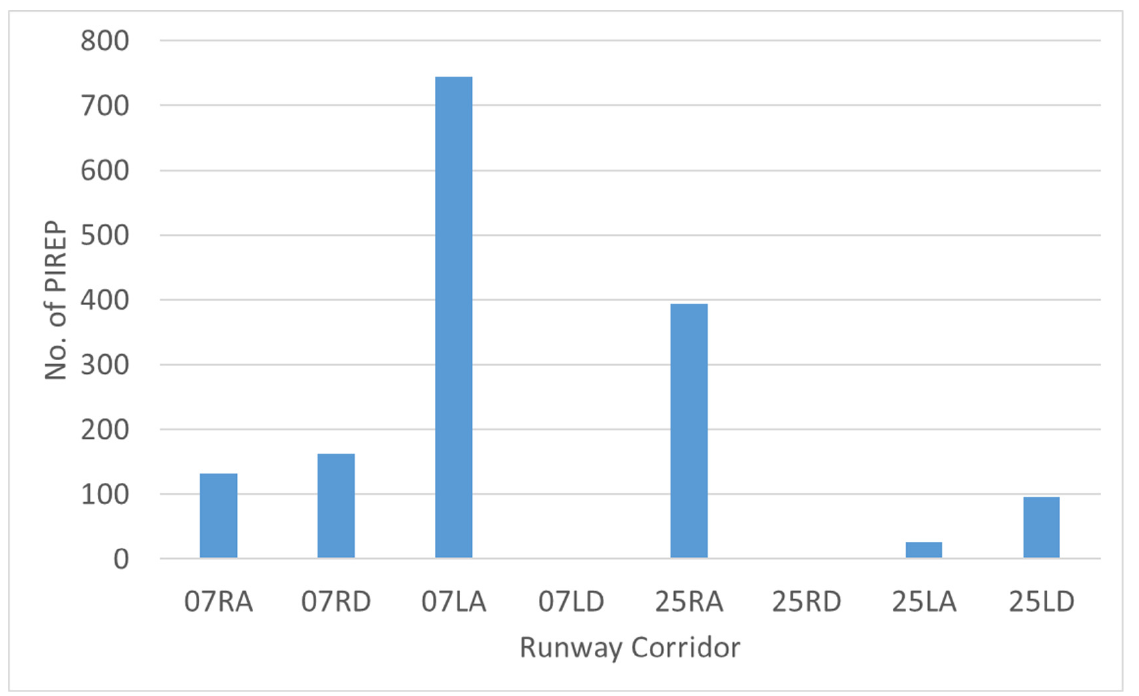
Figure 3. Distribution of windshear PIREP across the HKIA runway corridors during the study period.